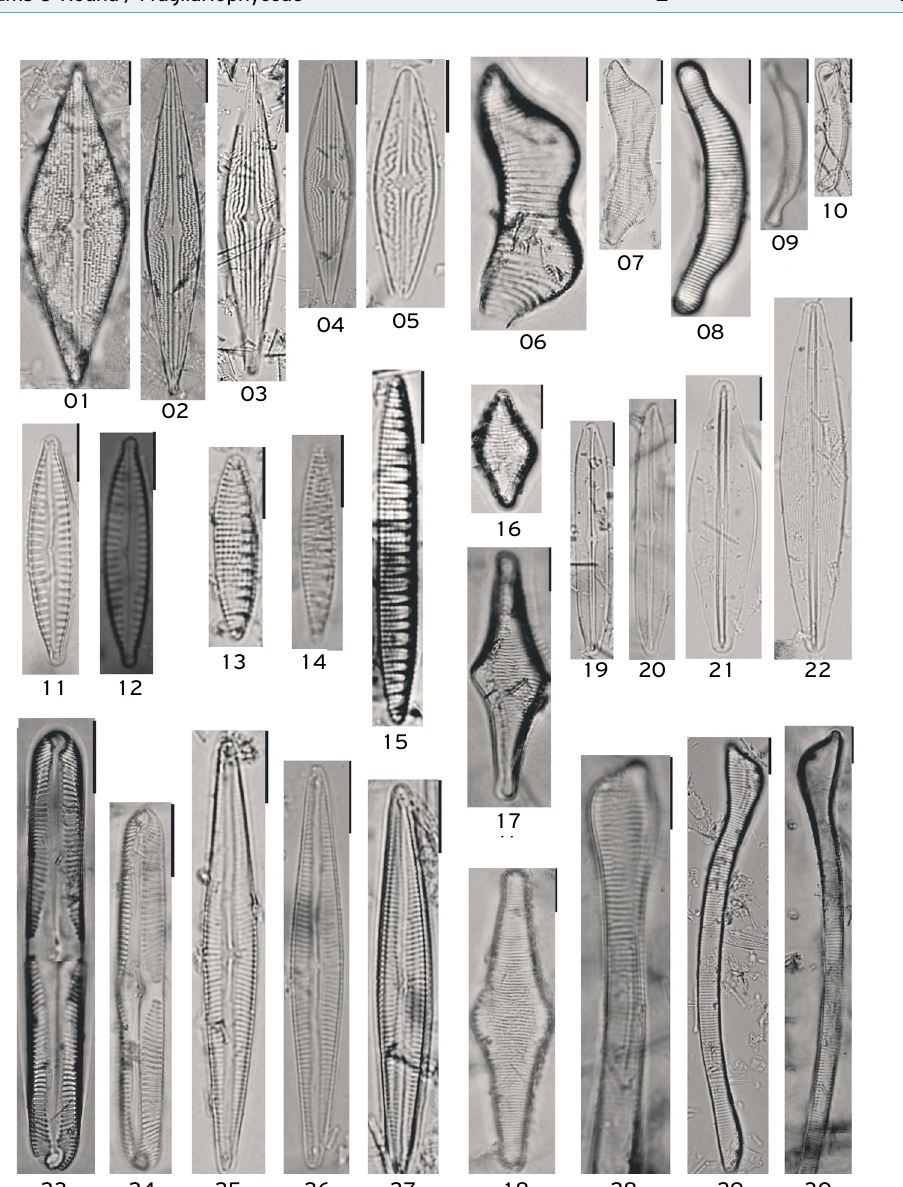
Figure 1. Diatom genera observed in the sample of Poultry Sec ® : 1–5) Brachysira Kützing; 6–10) Eunotia Ehrenberg; 11–12)